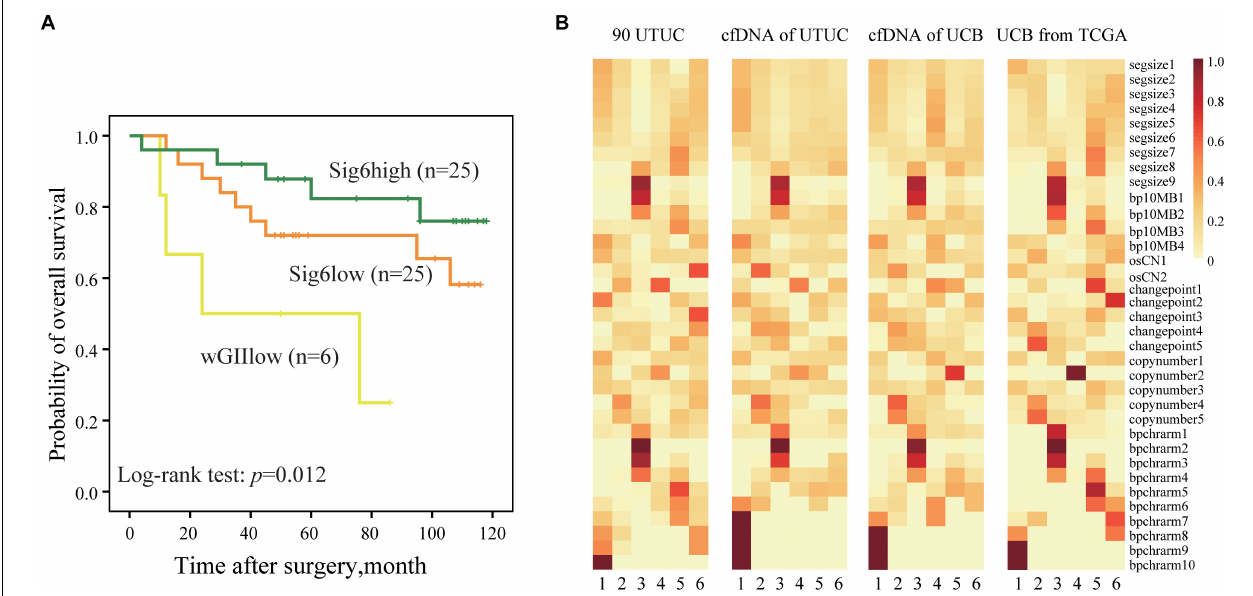
FIGURE 4 | The predictive significance of copy number CN signature. (A) The Kaplan–Meier analysis of overall survival in a UTUC validation cohort. (B) Heatmaps show component weights of CN signatures in Cohort I, Cohort III, and Cohort VI. UTUC, upper tract urothelial carcinoma; cfDNA, cell-free DNA; UCB, urothelial carcinoma of bladder; CN, copy